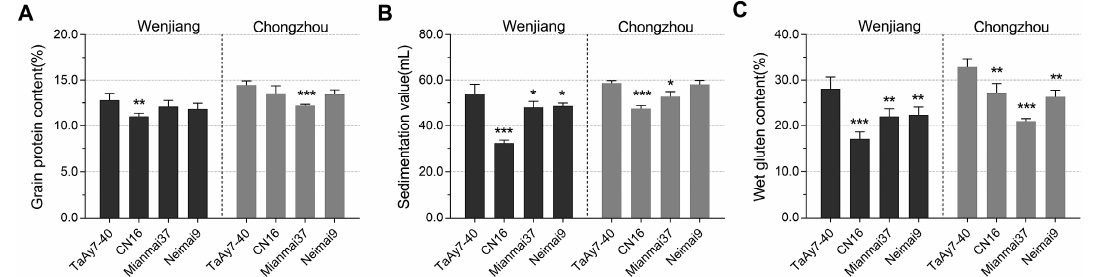
Figure 7. Two-way variance analysis of the difference for three quality traits of introgression lines TaAy7-40, CN16, and the two common wheat cultivars Mianmai 37 and Neimai 9 in Wenjiang and Chongzhou environments. The three PQPs include grain protein content ( A ), sedimentation value ( B ), and wet gluten content ( C ). *, **, and *** represent significance levels at 0.05, 0.01, and 0.001 between TaAy7-40 and each of the other three cultivars, respectively.